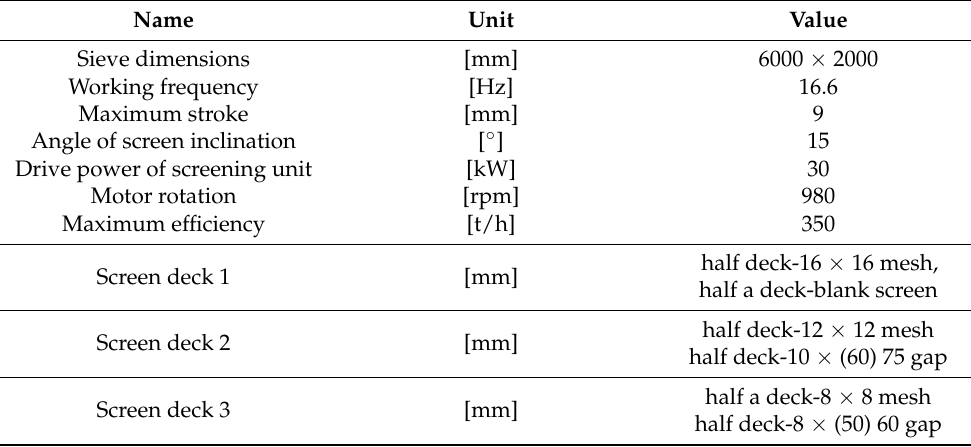
Table 3. Characteristics of the WSR 3-2.0/6.0 rotary screen.